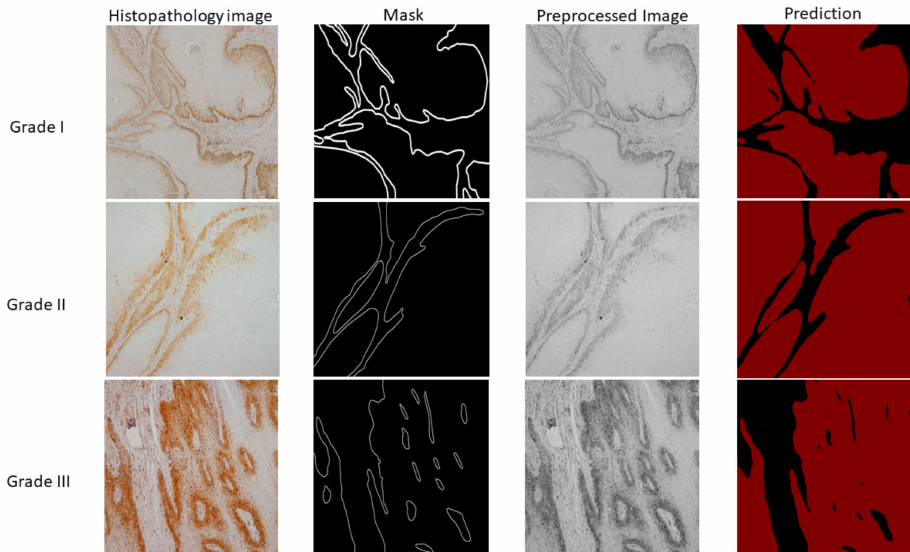
Figure 10. Visual representation of histopathology images, ground truth masks, preprocessed images, and semantic segmentation results. The first column represents samples of OSCC obtained by the clinician while the second column is corresponding ground truth mask. The third column represents samples after preprocessing which are afterwards used as input variables for semantic segmentation. Finally, the last column shows the prediction for three cases (Grade I, II, and III) where the black colour represents stromal tissue and the red colour represents epithelial